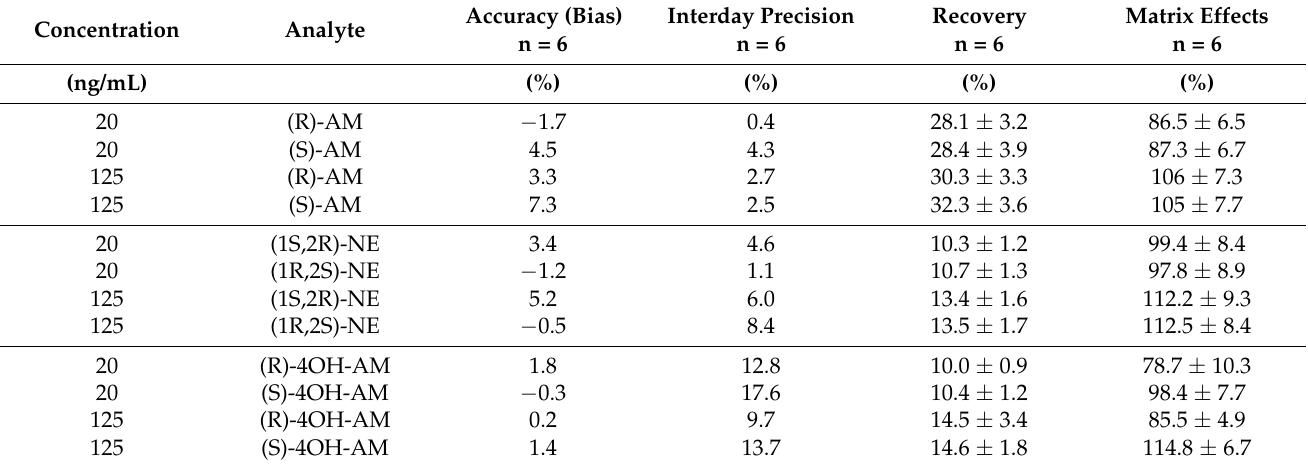
Figure 1. Multiple reaction monitoring (MRM) chromatograms for (R)-4-hydroxyamphetamine (1), (S)-4- hydroxyamphetamine (2), (1S,2R)-norephedrine (3), (1R,2S)-norephedrine (4), (R)-amphetamine (5) and (S)-amphetamine (6) at concentration levels of 20 ng/mL per enantiomer. MRM was split into two segments (A, B) at 8.0 min to reach a higher abundance. The total run time was 19 min. The following ion transitions are displayed in decreasing order of intensity (target ion underlined): 4-hydroxyamphetamine 152.1 → 107.0, 135.0, 77.0; norephedrine 152.1 → 134.0, 117.0, 115.0; amphetamine 136.1 → 91.0, 119.0, 65.0. Table 1. Validation results for the enantiomers of amphetamine (AM), norephedrine (NE) and 4-hydroxyamphetamine (4OH-AM) in